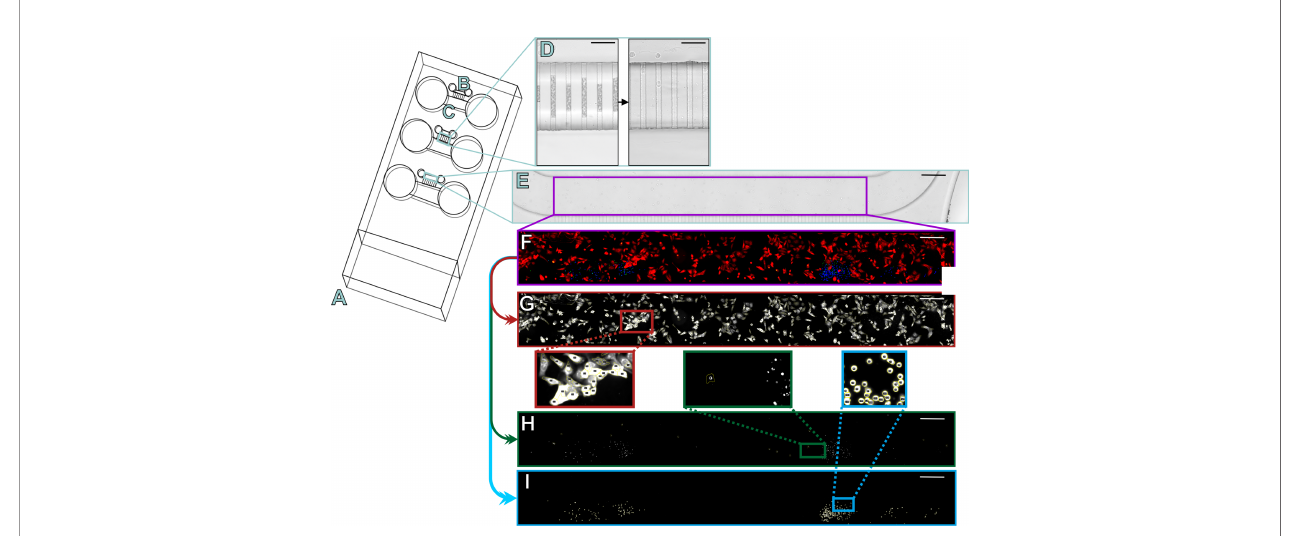
FIGURE 1 | Schematic of the micro fl uidic chips and semi-automated analysis of the three-dye system. The slide design contains three micro fl uidic chips (A) into which cancer cells were injected into the smaller channels (B) and lymphocytes into the larger channels (C) . The two channels were connected by microchannels, which were initially fi lled by air but opened in the fi rst 24 hours of injection (D) . The slides were imaged daily under a fl uorescence microscope to obtain a multichannel image, which was then cropped for analysis to contain only the cancer cell channel ( E ; purple rectangle). The fl uorescence signals were ampli fi ed and auto fl uorescence signals decreased manually with Image J to represent the channel (F) where cancer cells are shown in red, lymphocytes in blue, and apoptotic cells in green or yellow. Using the built-in features of ImageJ, our algorithm fi rst separated the different channels for analysis and started by counting the positive cells for the red channel (G) based on a minimum threshold, shape, and size. The green channel (H) was counted by checking the red intensities for a minimum green intensity. The blue channel (I) was counted based on a minimum threshold, shape, and size. Scale bar (D) 50 µm and E-I 300